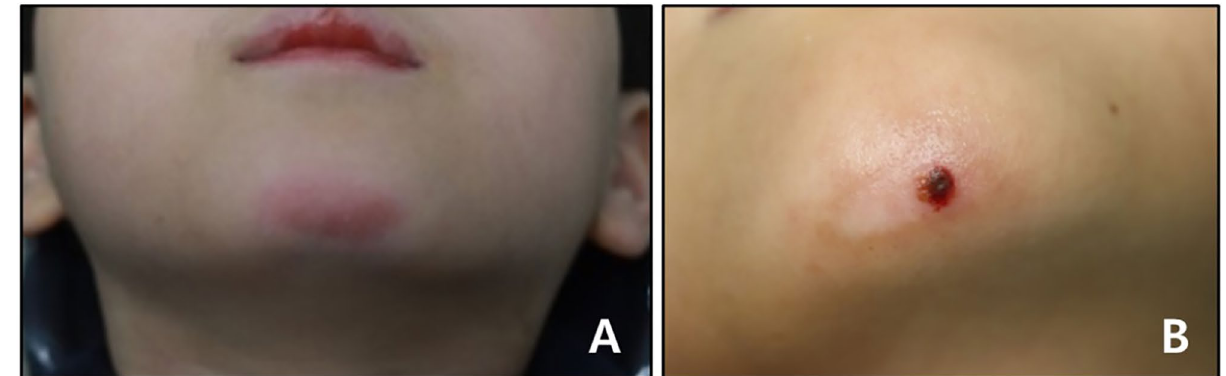
Figure 1. Skin irritation during facemask therapy. ( A ) Erythema (SII 1); ( B ) Laceration (SII 2).